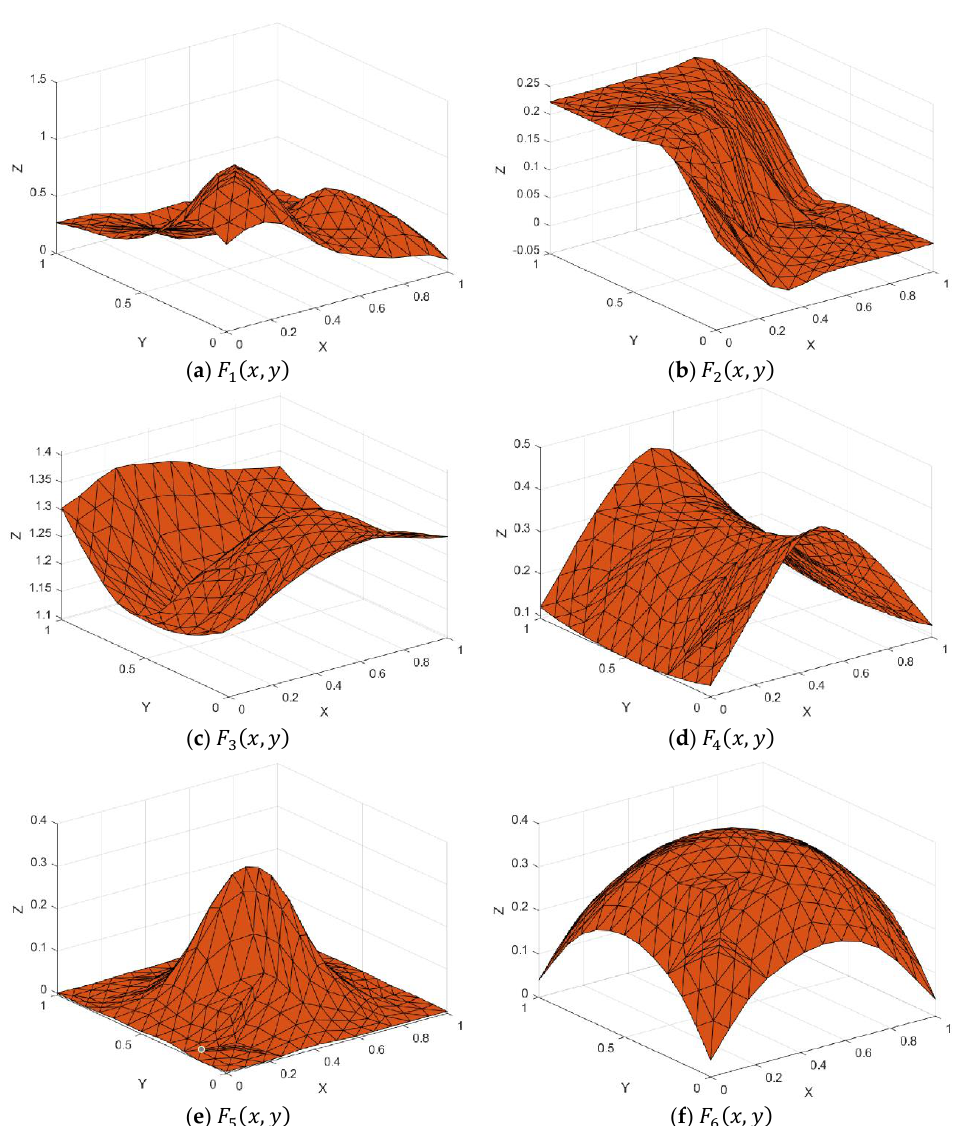
Figure 14. Surface interpolation using Foley and Opitz method and Choice 1 for 36 datasets.